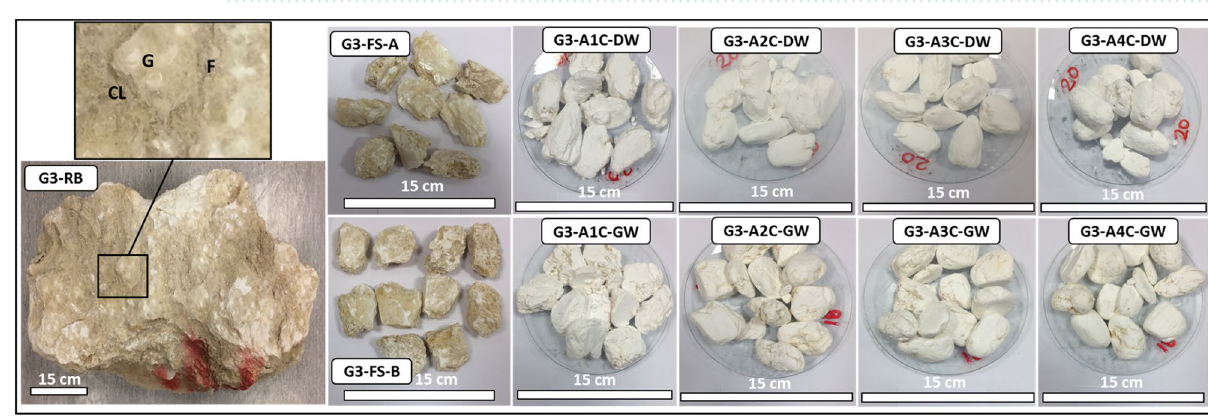
Figure 4. Representative evaporitic rock block (G2–RB; Group 2, Rock Block) and slake durability test samples cycled with distilled water and groundwater (1st–4th cycles). G2-FS-A represents Group 2, fresh sample, sample A, G2-A1C-DW to G2-A4C-DW after 1st–4th cycles with distilled water. G2-FS-B represents Group 2, fresh sample, sample B, G2-A1C-GW to G2-A4C-GW after 1st–4th cycles with groundwater. G = Gypsum, F = Fracture, CL = Clay.